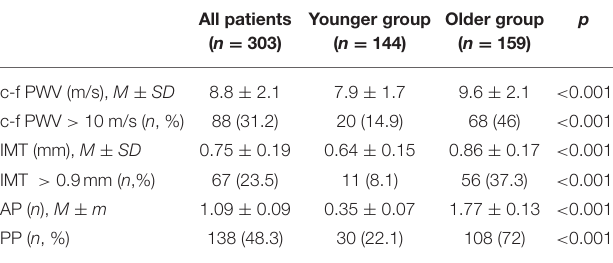
TABLE 2 | The characteristics of arterial wall in both age groups ( n =